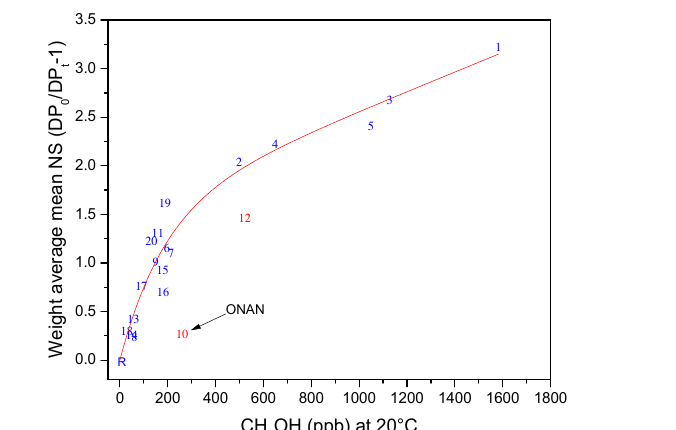
Figure 16. Methanol prediction model for core-type transformers [87].